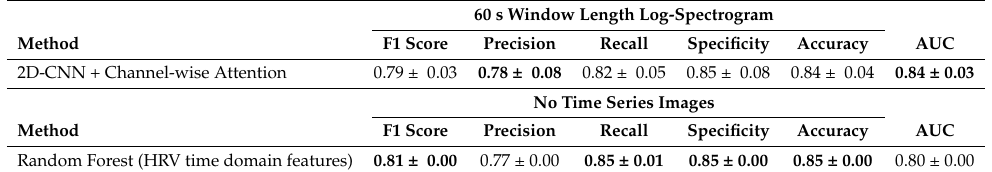
Table 5. Quantitative comparison of the proposed method (2D-CNN + Channel-wise Attention) and the baseline methods (traditional machine learning), using the original 60 s window length ECG as input. The results are presented as mean ± standard deviation. The best performance is indicated in